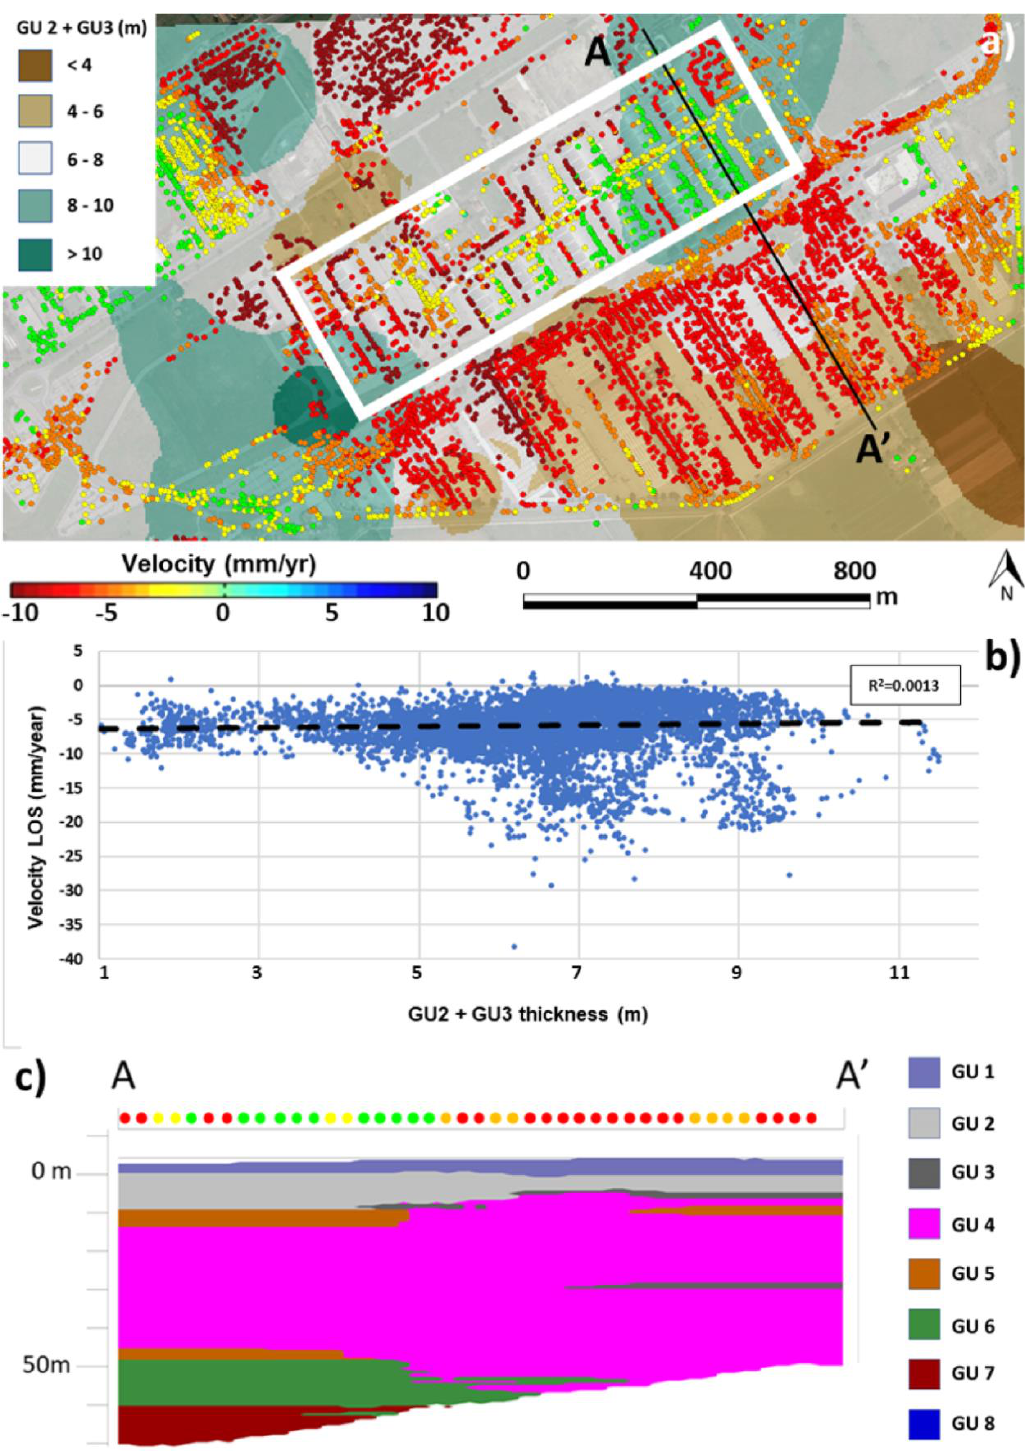
Figure 12. ( a ) Velocity of persistent scatterers of COSMO-SkyMed over a thickness map of compressible soils; the white rectangle highlights the presence of buildings on deep foundations. Most of the red dots within the rectangle refer to PSs located directly on the ground (i.e., paving) and not connected to the buildings; ( b ) Correlation diagram between PS velocity and soft-soil thickness in the region regardless of the characteristics (age of construction and foundation type) of the structure; ( c ) Geotechnical cross section (see a for the location) with a schematic positioning of the persistent scatterers localized over the cross section (the colour of the dots refers to the colour scale of Figure 12a).